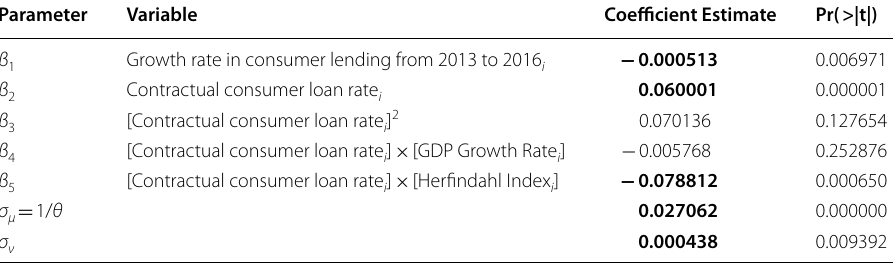
The data set includes LendingClub and 387 top-tier bank holding companies at the end of 2016 with plausible values of nonperforming unsecured consumer loans and total loans exceeding 10 percent of assets Skewness and D’Agostino skewness test of OLS residuals ( ∼ N ( 0,1 ) asymptotically ) : skewness = 4.7958 (> 0 ) ⇒ positively skewed test statistic = 16.7863 with p -value < 2.2E 16 ⇒ positively skewed with statistical significance. − Histogram and density of OLS residuals in the relative frequency scale appear in Appendix 3 Likelihood ratio test of H 0 : σ 2 µ = 0 vs. H 1 : σ 2 µ > 0 (asymptotically distributed as 50:50 mixture of χ 2 ( 1 ) and χ 2 ( 0 ) ): test statistic = 511.1877 with p -value <